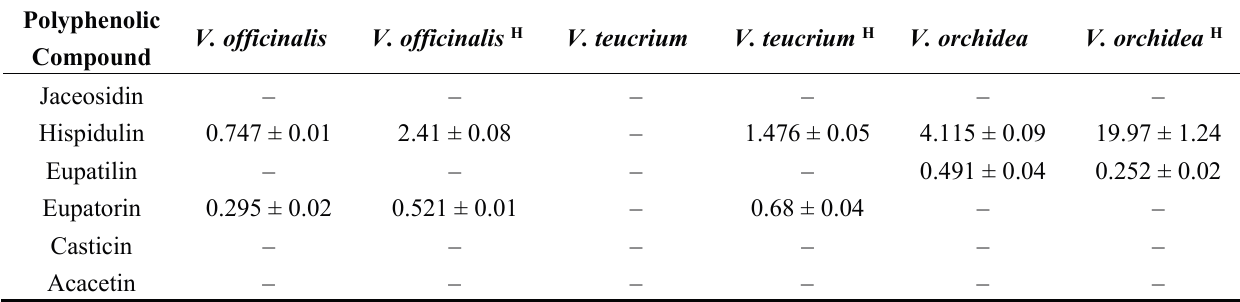
Table 3. The methoxylated flavones content in the analyzed samples ( μ g/g d.w. plant material). Polyphenolic